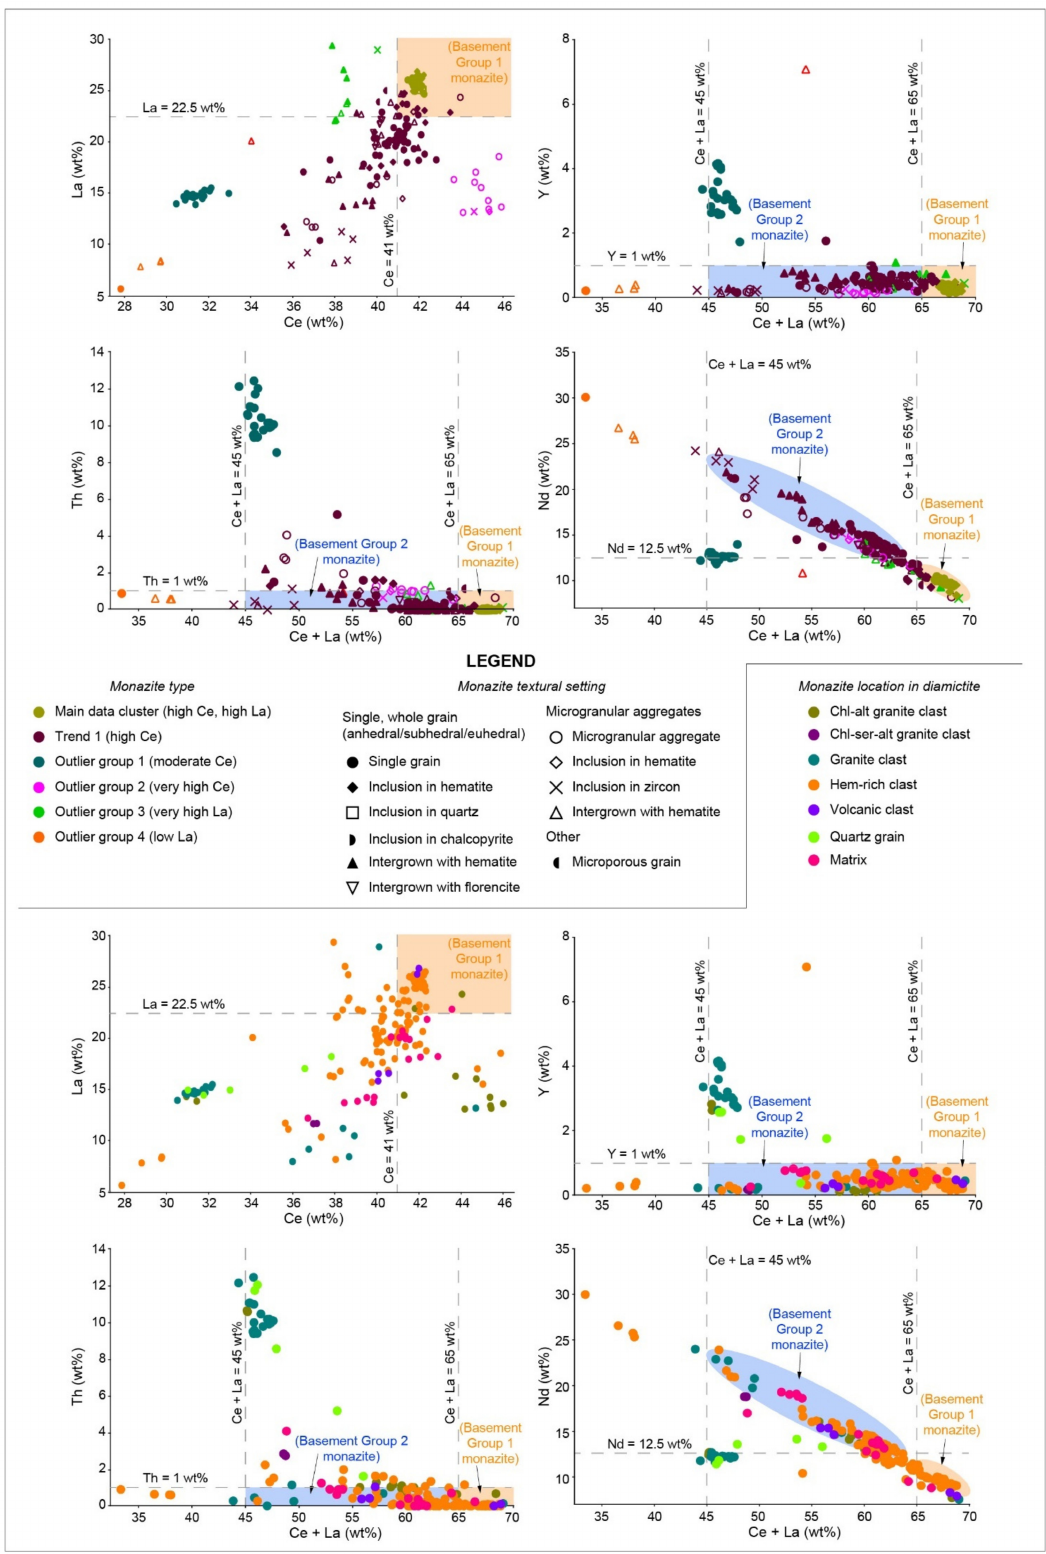
Figure 10. Plots of Ce vs. La and Ce + La vs. Y, Th and Nd for the Carrapateena cover sequence diamictite. Top set of plots is coloured by the monazite type (as per Figure 7) and shape depicts the monazite textural setting. Bottom set of plots is coloured by the location of the monazite within the cover sequence diamictite. The boundaries for Group 1 and Group 2 basement monazite Ce, La, Y, Th and Nd chemistry are